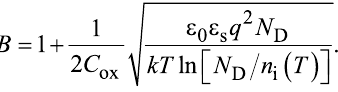
dependent of V DS ) is reached only for V G − V th < 20 V, corre- sponding to an accumulated electron density in the